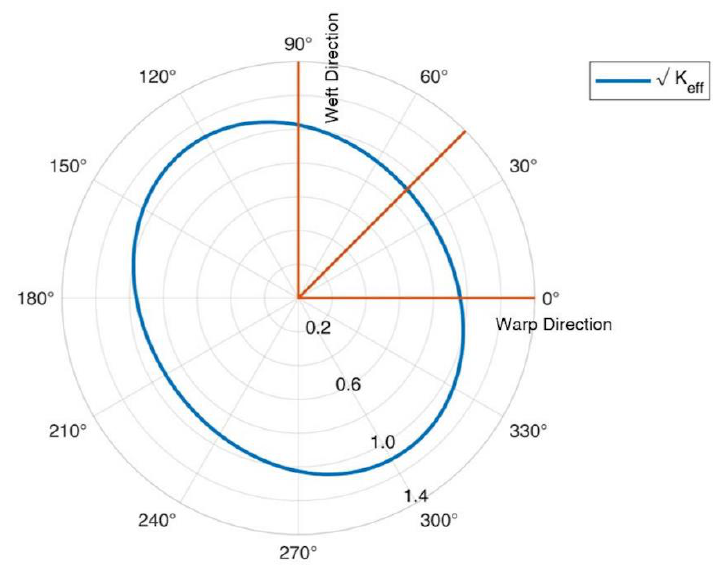
Figure 3. Effective permeability of the fiberglass textile plotted as a function of the orientation angle 𝜃 .